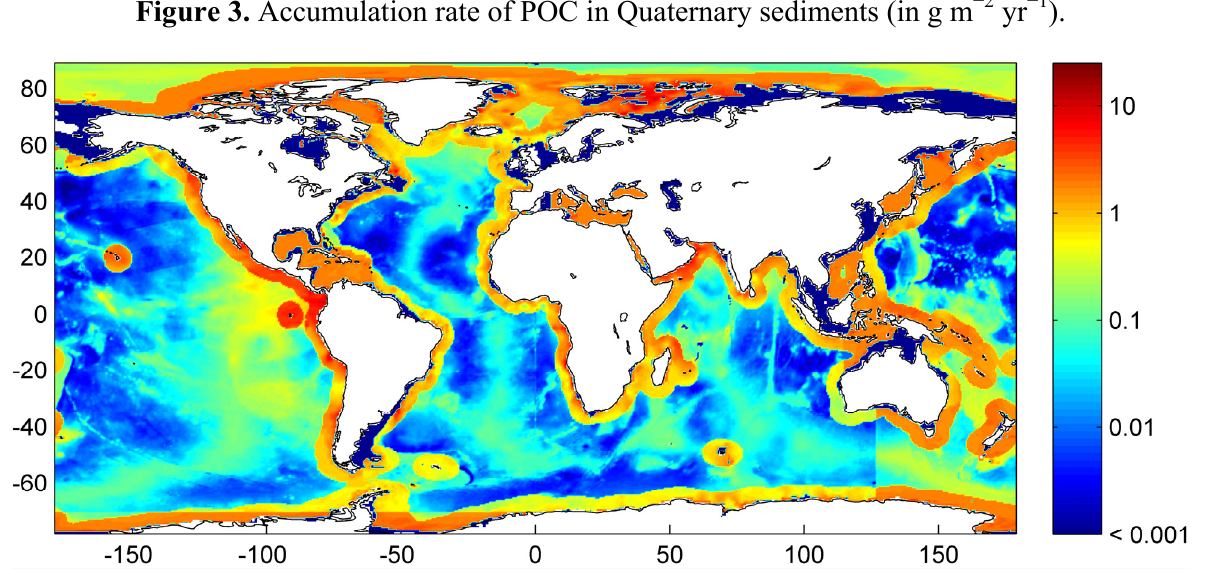
Figure 3. Accumulation rate of POC in Quaternary sediments (in g m − 2 yr − 1